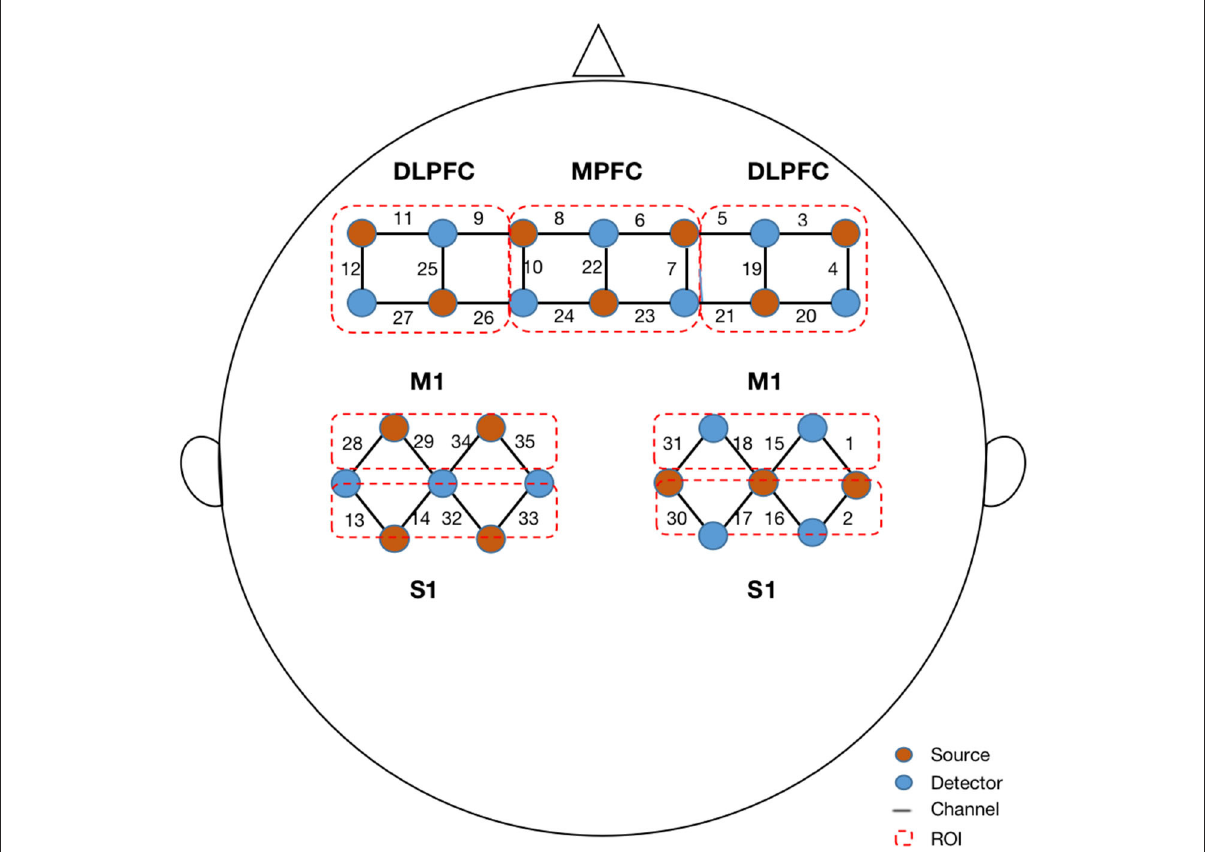
FIGURE1 Configuration of fNIRS channels. The red dots represent the light sources, and the blue dots represent the light detectors. In total, 14 sources and 14 detectors resulted in 35 channels encompassing seven regions of interest, specifically bilateral dorsal lateral prefrontal cortex (DLPFC), middle prefrontal cortex (MPFC), bilateral primary motor cortex (M1), and bilateral primary sensory cortex